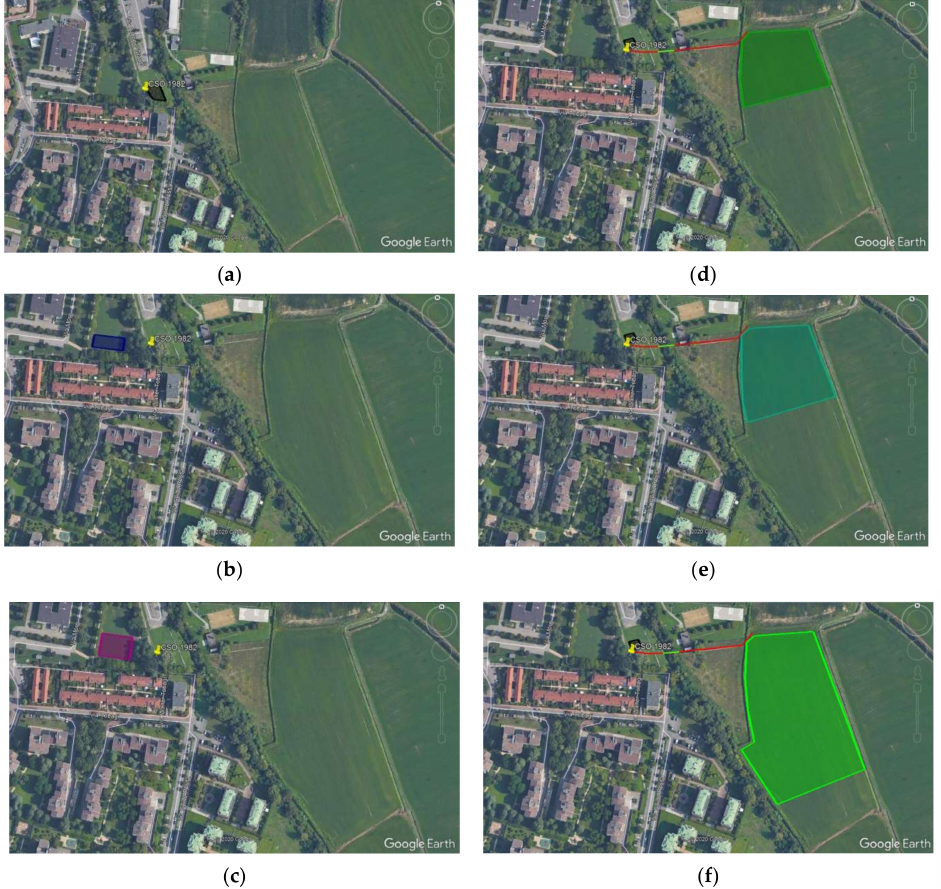
Figure 1. Plan view of the areal footprint and positioning of the different alternatives: ( a ) Alter- native 1.1, primary treatment only (primary only); ( b ) Alternative 1.2, first flush tank, minimum size according to local regulation (FFT—min); ( c ) Alternative 1.3, first flush tank, maximum size according to local regulation (FFT—max); ( d ) Alternative 2.1, constructed wetland with a single stage (VF); ( e ) Alternative 2.2, multistage constructed wetland (VF+ FWS); ( f ) Alternative 2.3, multistage constructed wetland sited in a newly developed urban park (VF + FWS